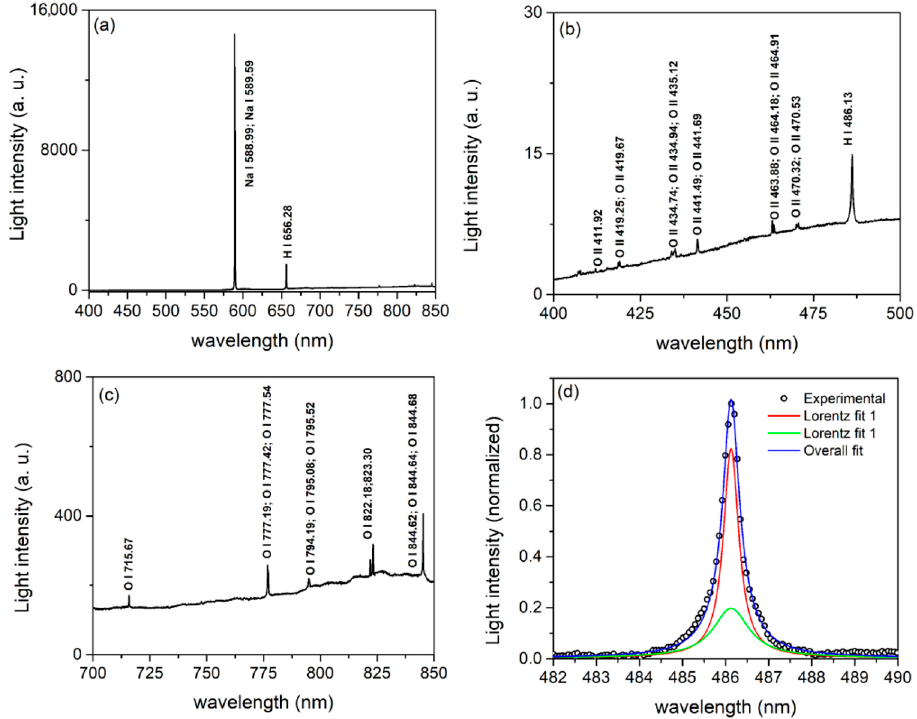
Figure 3. Optical emission spectra of MDs during anodization of tantalum in the range: ( a ) 400–850 nm; ( b ) 400–500 nm; ( c ) 700–850 nm; ( d ) The H β line profile fitted with two Lorentzian profiles.